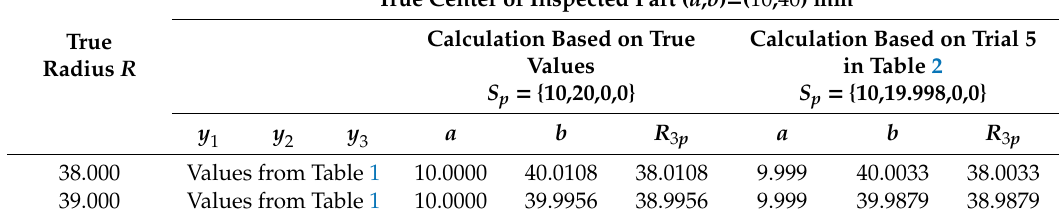
Table 3. TPFK algorithm based on mathematical simulation: computation of the { a , b , R 3 p } of the inspected part by using true and computed S p